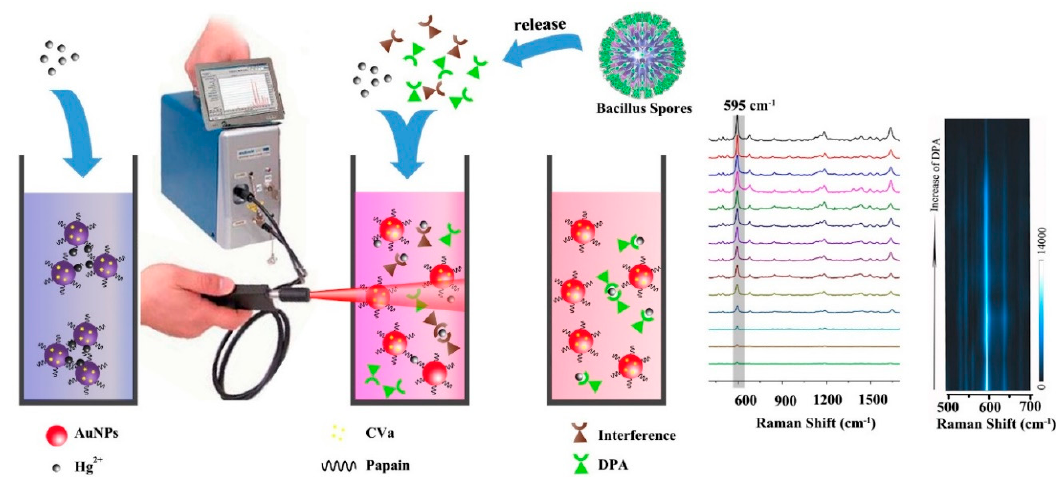
Figure 2. Schematic demonstration of Hg 2+ ions aided SERS detection of DPA and SERS measurements. Reproduced from ref. [115], with permission from American Chemical Society, 2017.